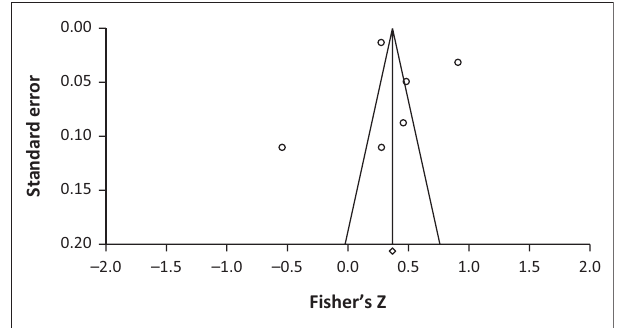
FIGURE 4: Funnel plot depicting publication bias for the association between human resource management and operational